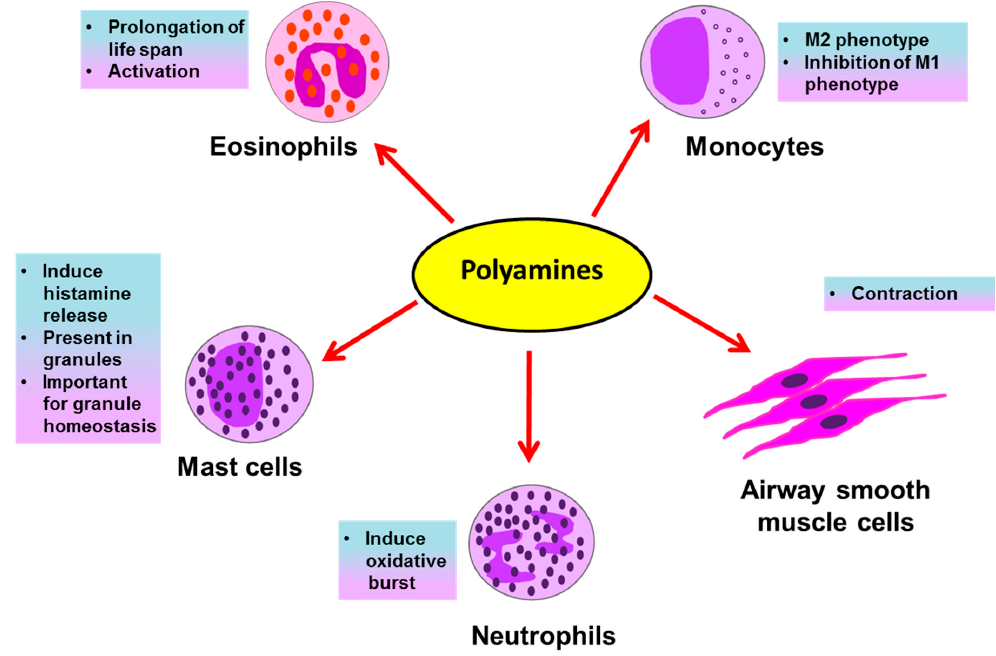
Figure 2. Possible effects of polyamines on immune and structural cells in asthma.